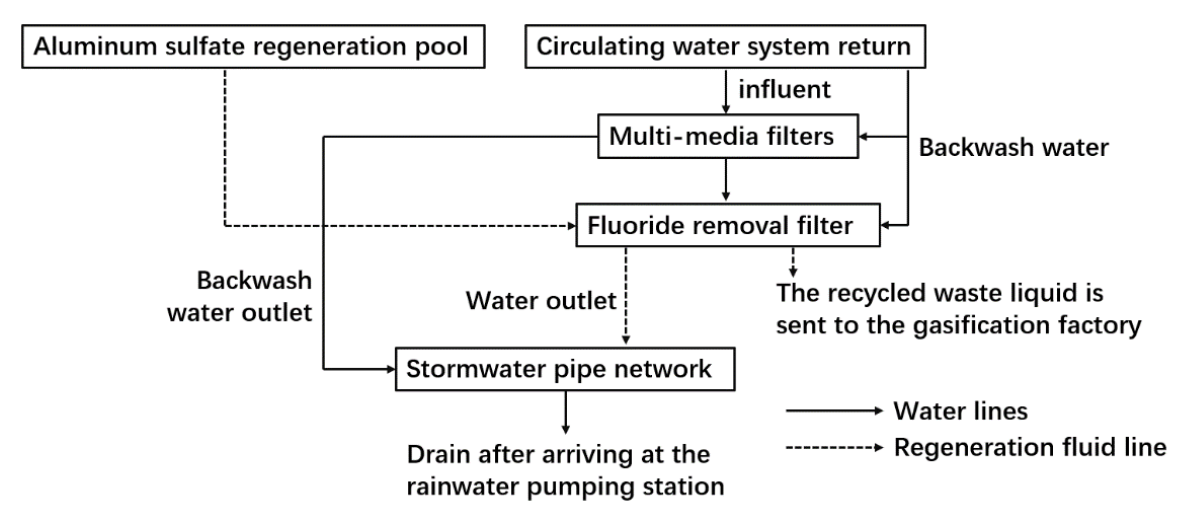
Figure 5. Flow chart of filtration − adsorption process.